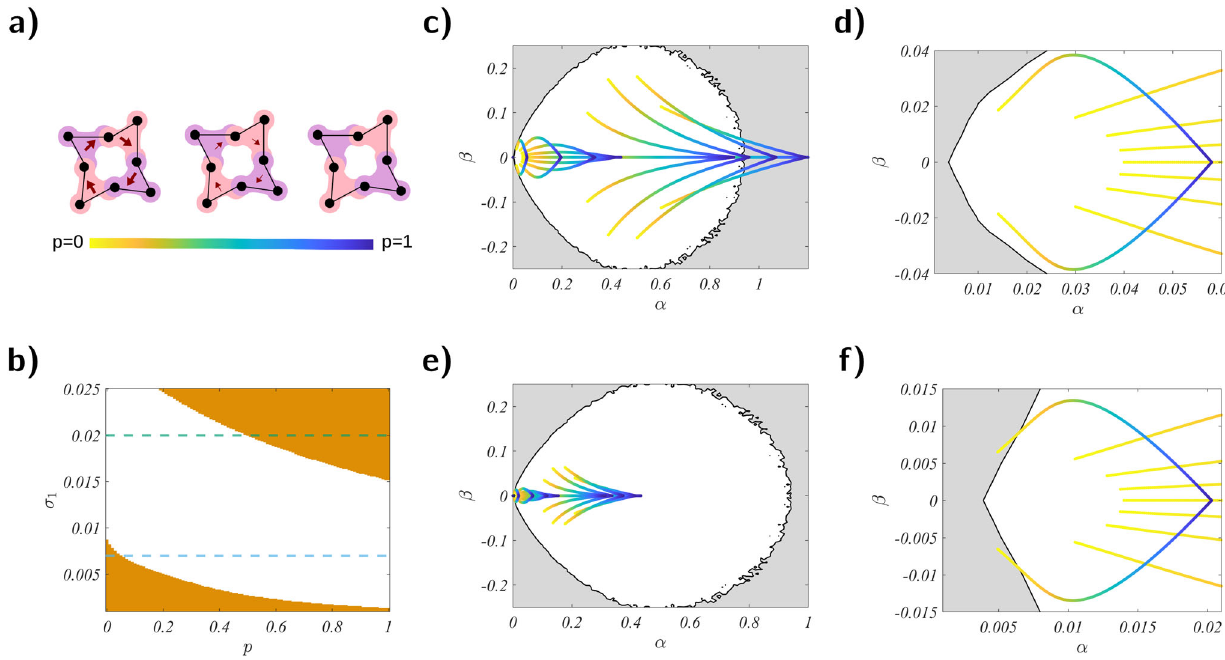
Fig. 2 Directionality induced (de)synchronization. a The weighted hypergraph as a function of the parameter p , controlling the transition of the hyperedges from directed to undirected (the structure is schematically represented for N = 8 nodes). Each undirected 2-hyperedge can be seen as the combination of three directed hyperedges, two of which have a weight p ∈ [0, 1]. When p = 0, a triplet of nodes interacts only through a single directed hyperedge, whereas when p = 1, the hypergraph is symmetric. b Synchronization diagram in the plane ( p , σ 1 ) for a system of Rössler oscillators with x - x cubic coupling, being σ 1 the coupling strength of the pairwise interactions. The white area indicates the region of stability, while the orange one the region where the synchronous solution is unstable. The horizontal dashed lines represent two values of σ 1 for which the system transits from a synchronized to an unsynchronized state as a function of p (green line), and the other way around (blue line). Panels c – f show the locus of eigenvalues of the effective Laplacian matrix M as a function of p , for a weighted hypergraph with N = 20 nodes at two different values of σ 1 (color coding is such that the directed case p = 0 is represented in yellow, and the symmetric one p = 1, in blue). In the background, the white area indicates the region identi fi ed by a negative Master Stability Function (MSF), the black line the boundary of this region, and the gray area the region where the MSF is positive. Panels d and f represent a zoom of the area close to the origin of panels c and e , respectively. Panels c and d show a setting where the symmetric topology drives the system unstable, whereas with a directed hypergraph the synchronization manifold results stable. Panels e and f display a case for which the symmetric topology admits a stable synchronization state, while the directed hypergraph triggers the instability. The coupling strength for panels c and d is set to σ 1 = 0.02, while for panels e and f to σ 1 = 0.007. In both cases we set the ratio r 2 = σ 2 / σ 1 = 10, where σ 2 is the coupling strength of the three-body